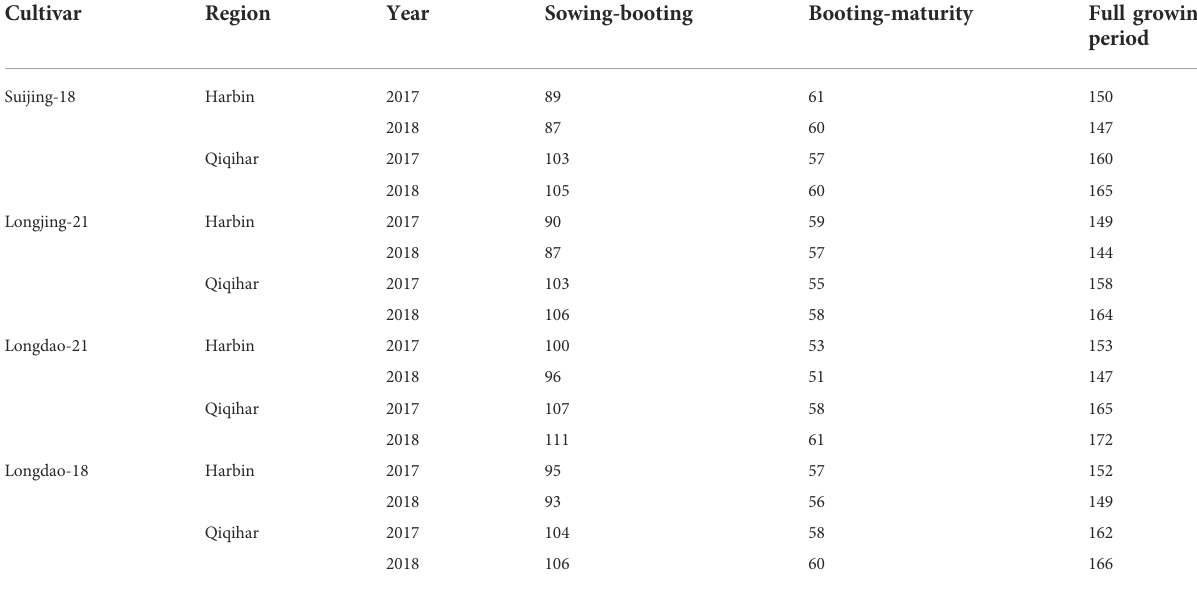
TABLE 1 Comparability of growing periods (days) of rice cultivars in Harbin and Qiqihar, 2017 and 2018. Cultivar